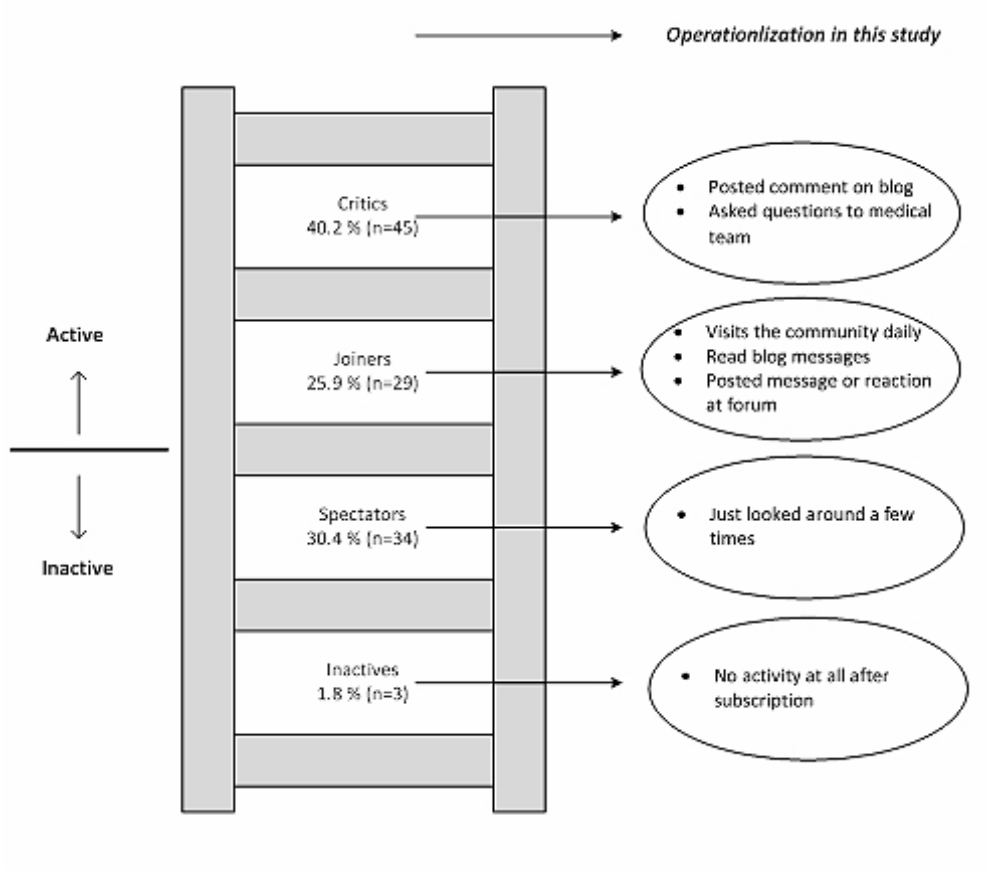
Figure 2. Types of users by self-reported activity according to a participation ladder.